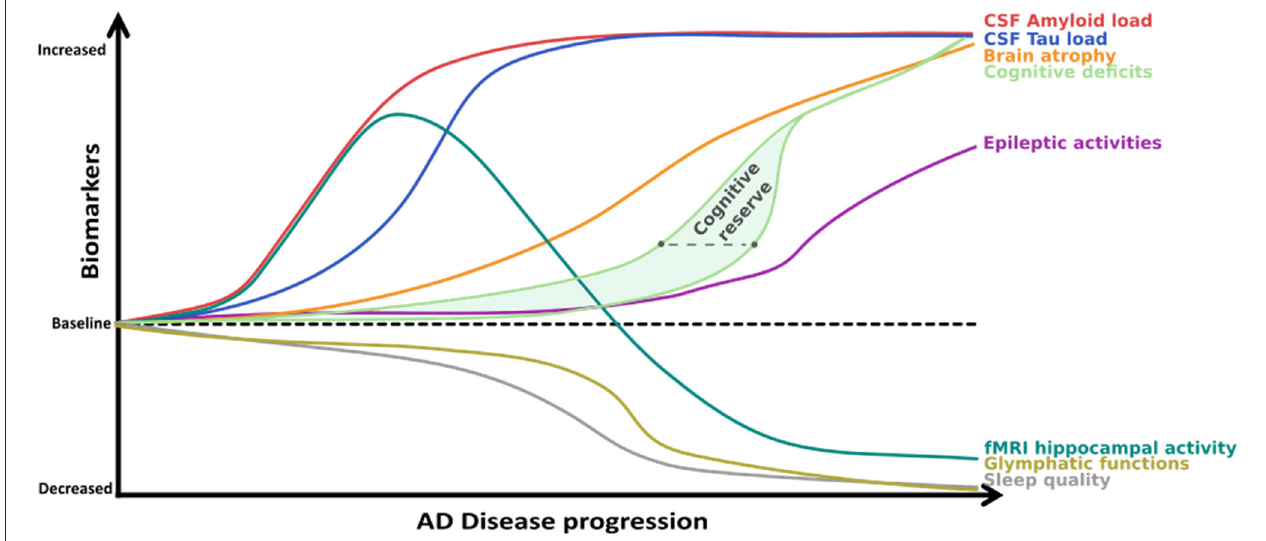
FIGURE 5 | Proposed model of biomarker-and cognitive decline progression over the course of AD. High cognitive reserves compensate on a functional level for marked Amyloid and Tau aggregation and atrophy may lead to delayed diagnosis. This might explain why EA is most often detected in highly educated participants who are (seemingly) in the mild stages of the disease. However, once compensation is no longer possible and EA becomes more frequent or probable, the cognitive decline might be steeper, which is compatible with the fast progression noted in AD patients with E/EA. Figure adapted from (33) with permission. The gray dashed line represents the approximate time of